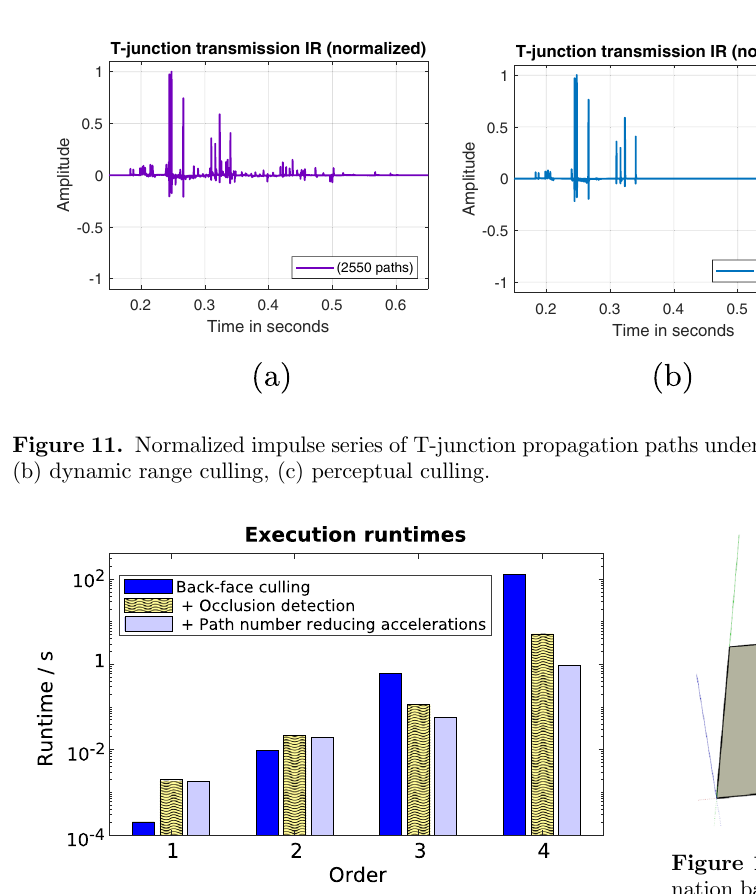
Figure 12. Accumulated run-times for the scenario excluding pre-processing. The dark blue bars depict the inclusion of back- face culling, the yellow bars the additional inclusion of occlusion detection and light blue bars further include the path number reducing methods.